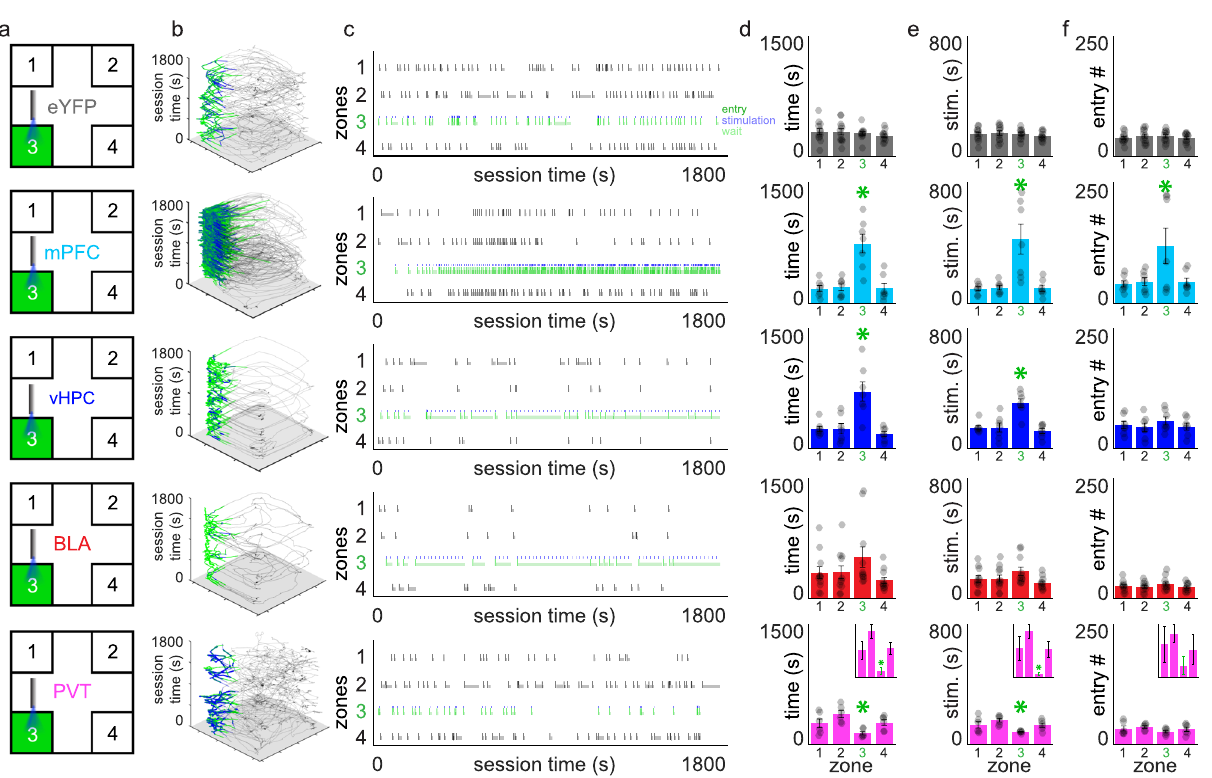
Fig. 2 Self-stimulation of different NAcSh inputs results in input-speci fi c behavioural strategies. Different NAcSh input groups are depicted by different colours throughout: eYFP controls (gray, n = 12), mPFC → NAcSh (cyan, n = 7 mice), vHPC → NAcSh (blue, n = 7 mice), BLA → NAcSh (red, n = 11 mice), and PVT → NAcSh (pink, n = 6 mice). a Mice explored the spatial arena during a 30 min acquisition session with one active (3; green) and three inactive (1,2,4) corner zones. b x – y position tracking for representative mice throughout the session (green = active zone position; blue = stimulation position). c Raster plots showing individual zone entries over time in representative mice (from b). Green ticks indicate active zone entries, blue ticks indicate stimulation onset, green shading indicates time spent waiting during the timeout in the active (full height shading) and inactive (half height shading) zones. d Total time spent across the four corner zones. Active-zone time was increased in mPFC → NAcSh and vHPC → NAcSh mice and decreased in PVT → NAcSh mice (inset presented for clarity). e Total stimulation (real or mock) received in each corner zone. Stimulation time was increased in mPFC → NAcSh and vHPC → NAcSh mice and decreased in PVT → NAcSh mice. f Total entries made into the different corner zones. Active-zone entries were only increased (vs. inactive zones) in mPFC → NAcSh mice. Despite the reduced stimulation received in PVT → NAcSh mice, these mice did not avoid entry into the active zone. Group data are expressed as mean ± SEM. Main zone effects within each group and metric were identi fi ed using one-way ANOVAs. * p < 0.05 active vs. all other inactive zones, Student ’ s post hoc